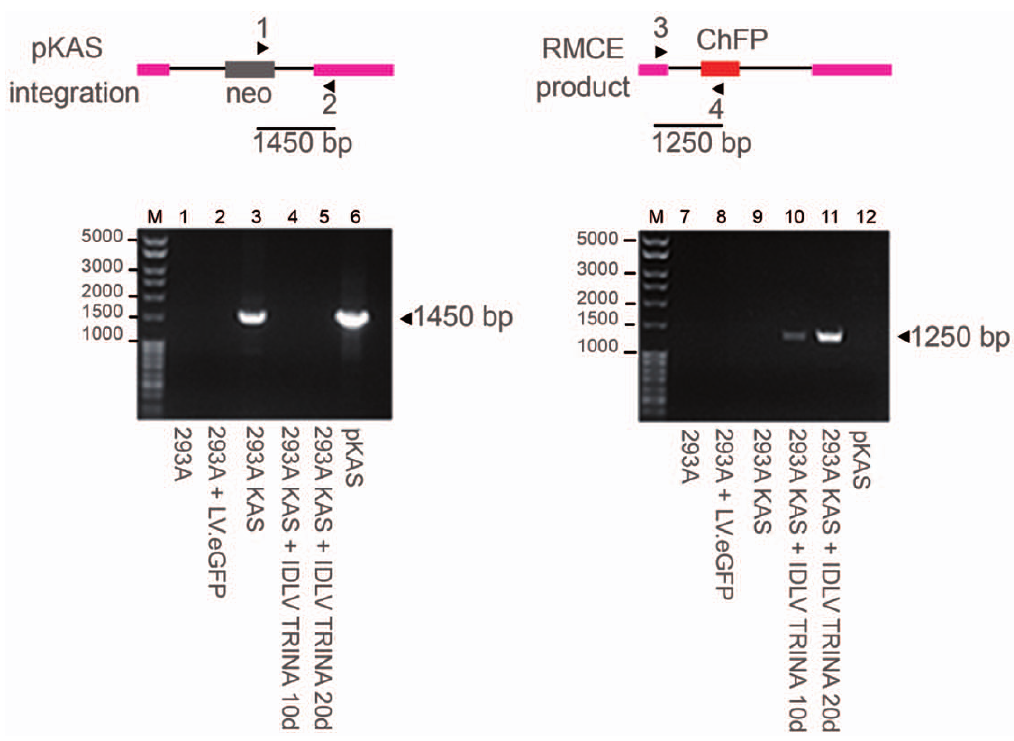
Figure 4. PCR analysis of genomic DNA isolated to verify RMCE reaction. PCR analysis of genomic DNA extracted from the HEK293A cells (lane 1 and 7), or transfected with pKAS (293AKAS) (lanes 2 to 5 and 8 to 11). Cells were transduced with control virus IDLV.CMVeGFP (lanes 2 and 8), IDLV.TRINA (lanes 4, 5, 10 and 11), or non-transduced (lanes 3 and 9). Positive control is DNA from pKAS (lanes 6 and 12). The 1250 bp band is indicative of RMCE between KAS and TRINA cassettes and the 1450 bp corresponds to integrated pKAS band. IDLV.TRINA/10 and IDLV.TRINA/20 correspond to DNA obtained after from cultures selected during10 and 20 days with hygromycin respectively. The sizes of the DNA fragments in the marker line M are